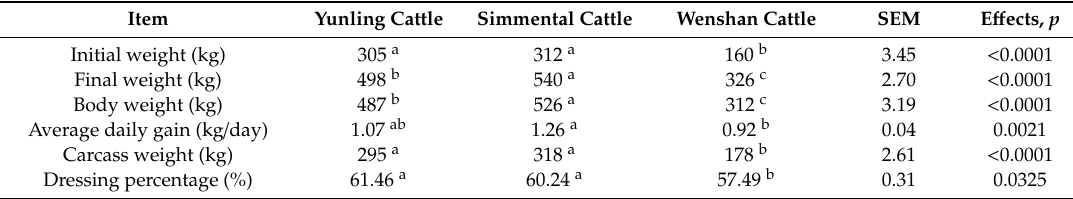
Table 1. The growth performance and carcass trait of the cattle